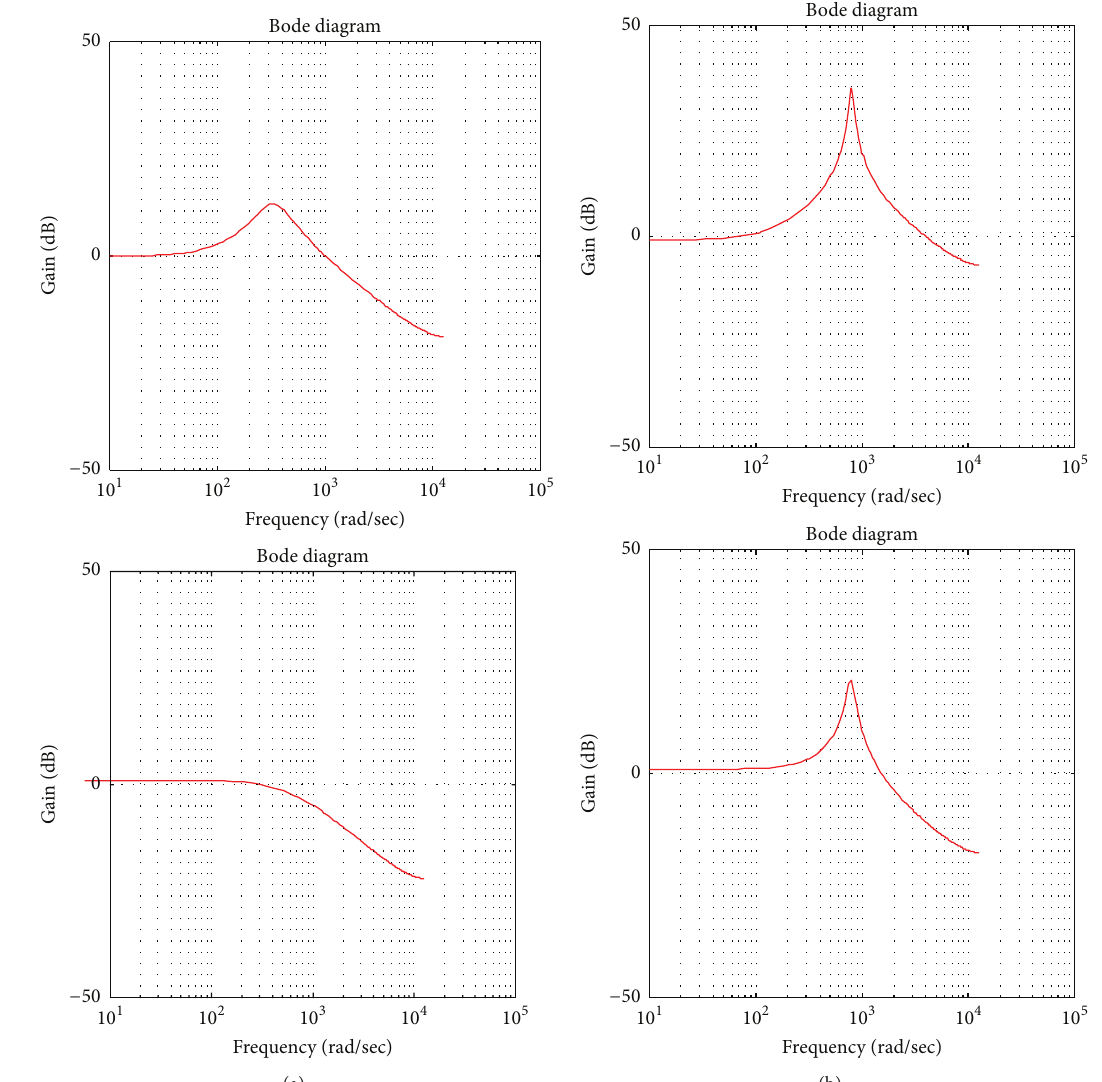
Figure 9: Bode plots for the fixture B at sections 1 and 3 for 120 rpm (a) and 240 rpm